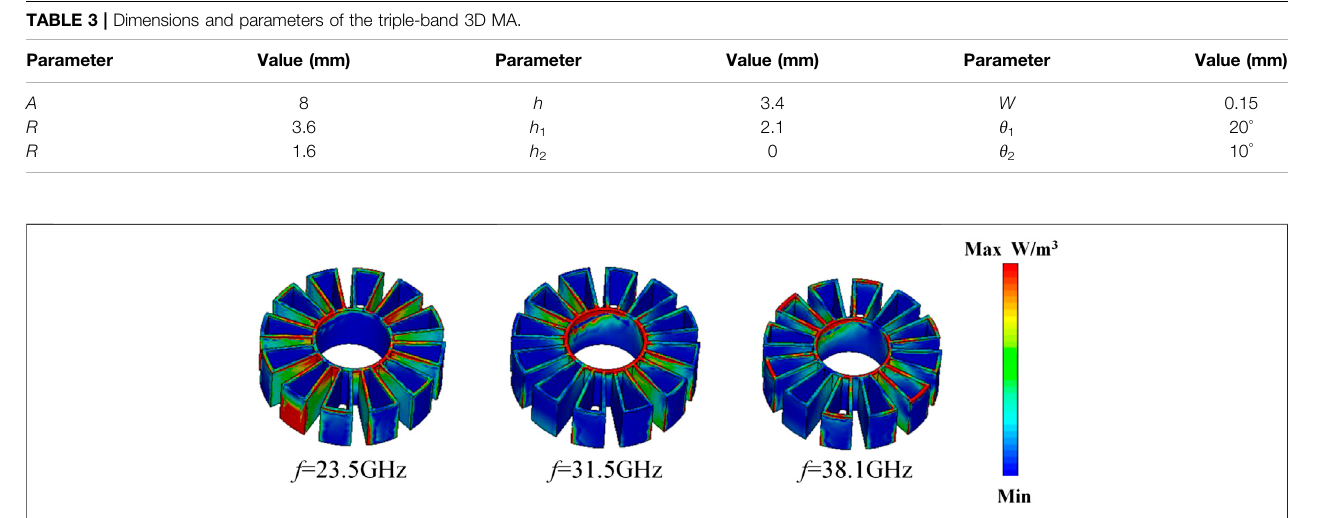
FIGURE 9 | Power loss density distributions on the 3D resonator at three peak absorption